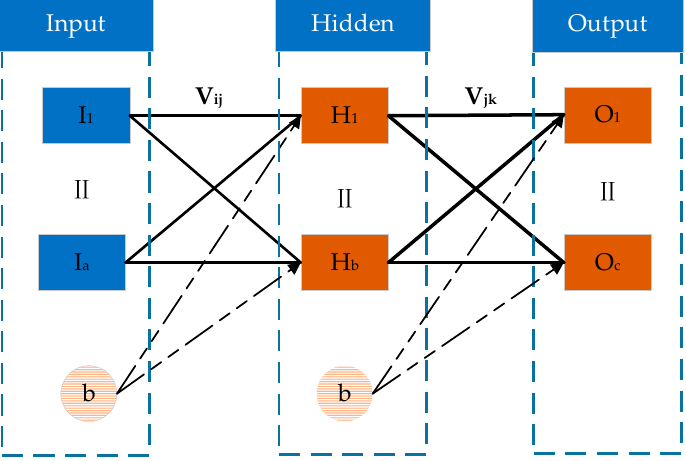
Figure 4. Schematic diagram of the neural network algorithm principle.